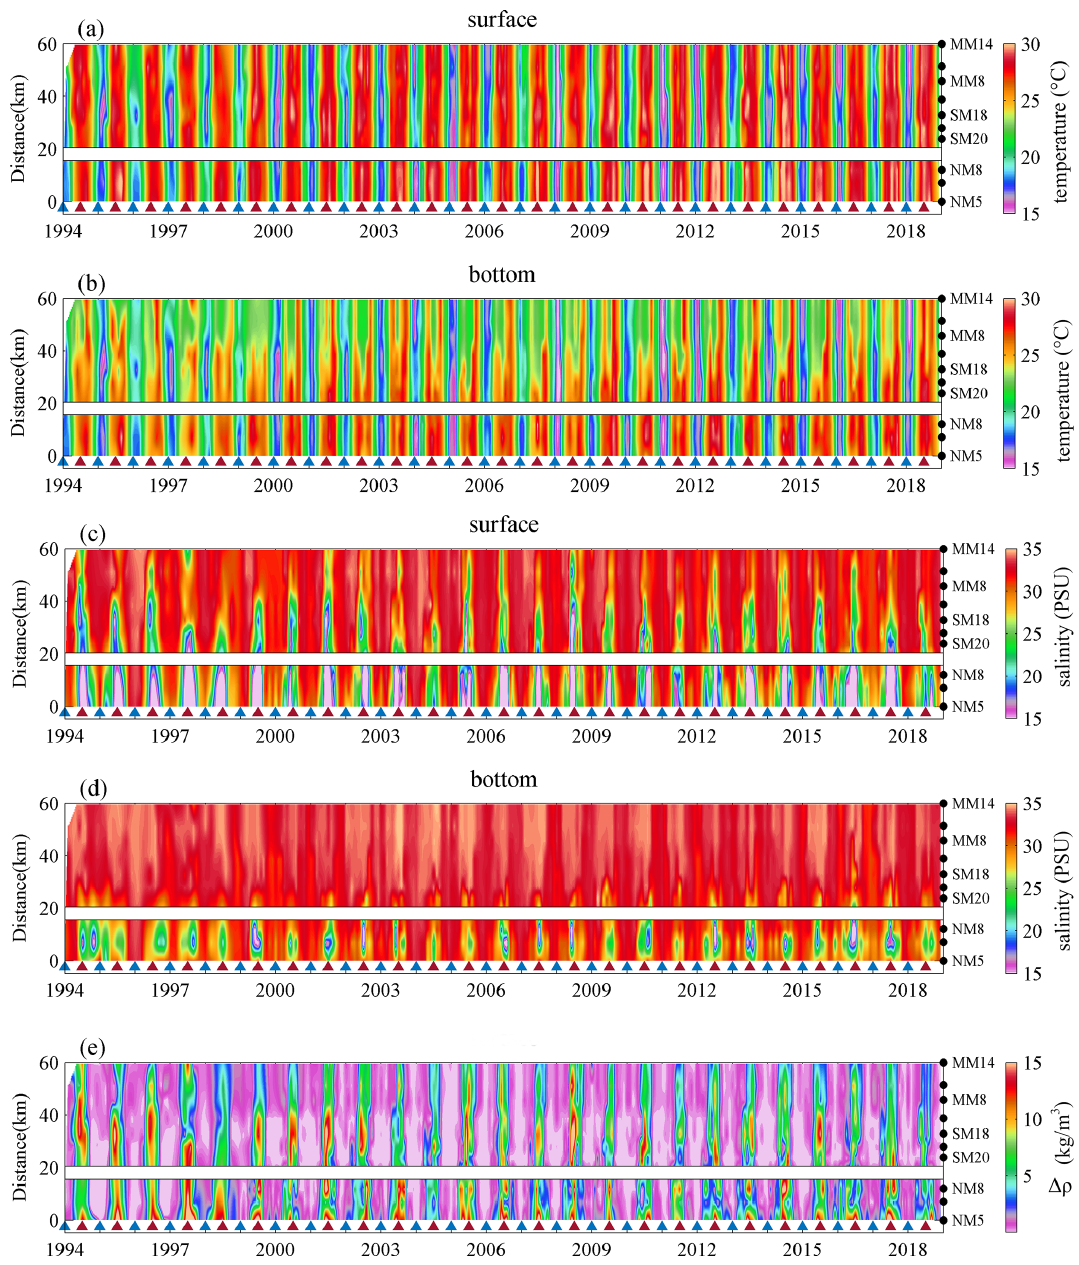
Figure 2. Spatiotemporal distribution of temperature (a, b) , salinity (c, d) in the surface and bottom waters, and vertical density differences (e) during 1994–2018. Note that the stations investigated are denoted by the black dots on the right of the figure. The blue triangles point to each month of December over 25 years, while the red ones point to